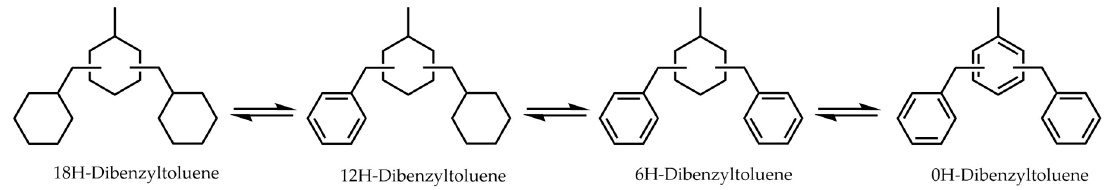
Figure 2. Schematic drawing of the LOHC system perhydro-dibenzyl-toluene / dibenzyl-toluene and its stable forms with different hydrogenation levels.